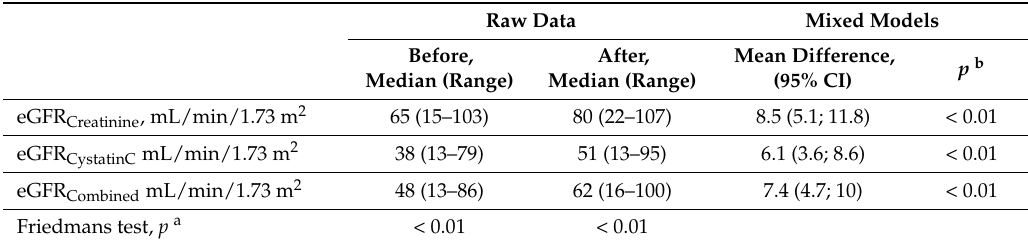
Table 3. Estimated glomerular filtration rate (eGFR) from the Chronic Kidney Disease Epidemiology Collaboration (CKD-EPI) before, and after, amputation, and mean difference between